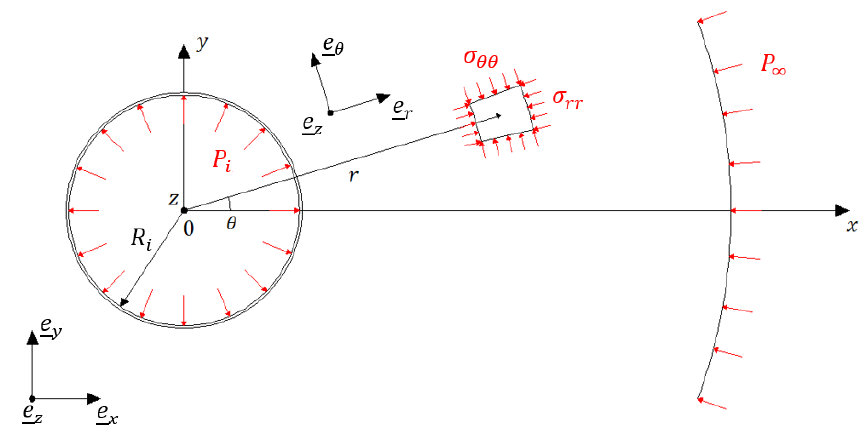
Figure 3. Cross-section of an axisymmetric tunnel within an elastic-plastic rock mass.